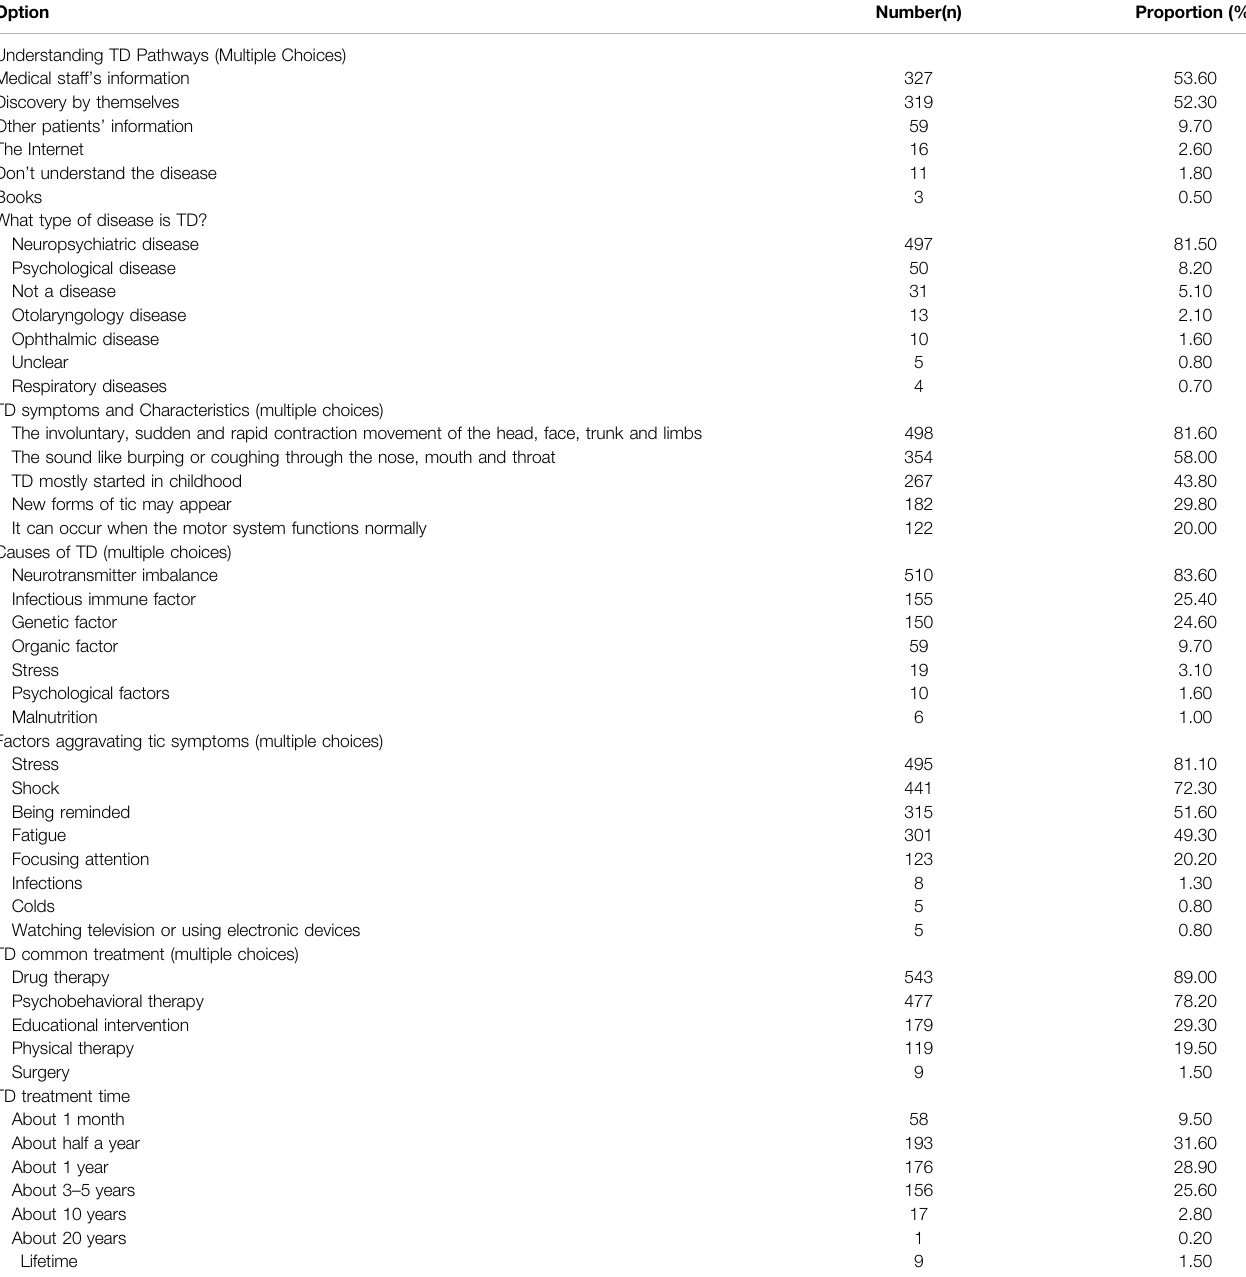
TABLE 5 | Guardian ’ s cognition of TD (N =